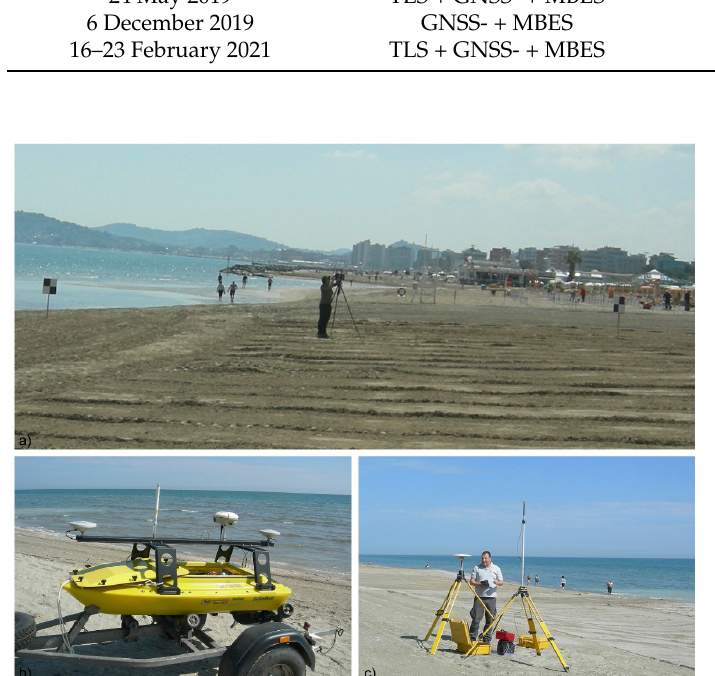
Figure 5. ( a ) TSL survey; ( b ) ASV used for multibeam bathymetric surveys; ( c ) GNSS-NRTK system for positioning. for Regarding the data acquired by Arpae in 2017 and 2018 (Table 1), it is important to point out that surveys were carried out with the same equipment and the data are consid- ered fully comparable with those of subsequent surveys. In this case, point shapefiles with a resolution of 1 m were provided for the area. Similarly to the results of the other surveys, the point shapefiles were firstly transformed in a TIN and then in a raster grid (Arc ASCII Grid).